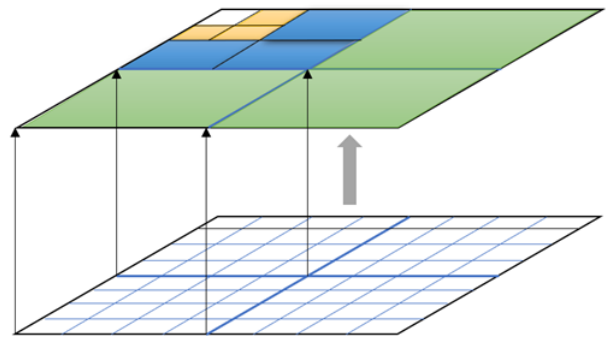
Figure 5. Single-scale to multi-scale aggregation.